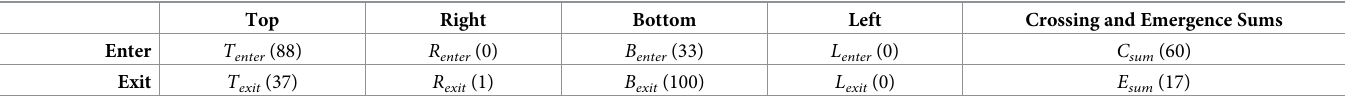
Table 1. Example output summary table. See Eqs 1 and 2 for explanation of the crossing and emergence sums. The values represented in parentheses are the actual val- ues calculated for the example shown in Fig 1 (see also S1 Video). Top Right Bottom Left Crossing and Emergence Sums Enter T enter (88) R enter (0)